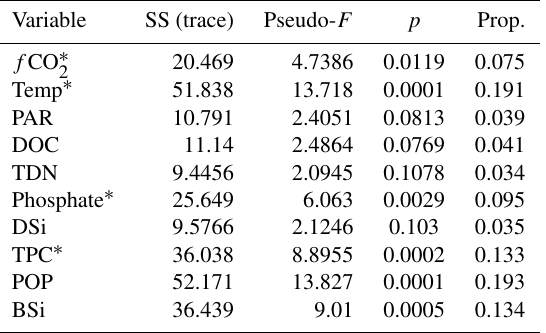
Table 6. Summary of a DistLM procedure for modelling the rela- tionship between physicochemical variables and a multivariate as- semblage, comprising variables of the bacterial and phytoplankton community. The resemblance matrix (Bray–Curtis similarity coeffi- cient) was based on log( X + 1) transformed abundances of Pico I-III, Nano I-II, FL bacteria (HDNA, LDNA), PA bacteria, Synechococ- cus spp. and Chl a . Redundant physicochemical variables were re- moved prior analysis. Therefore, PON and pH were excluded from the subsequent analysis due to high correlations ( r s >0.9) to TPC and f CO 2